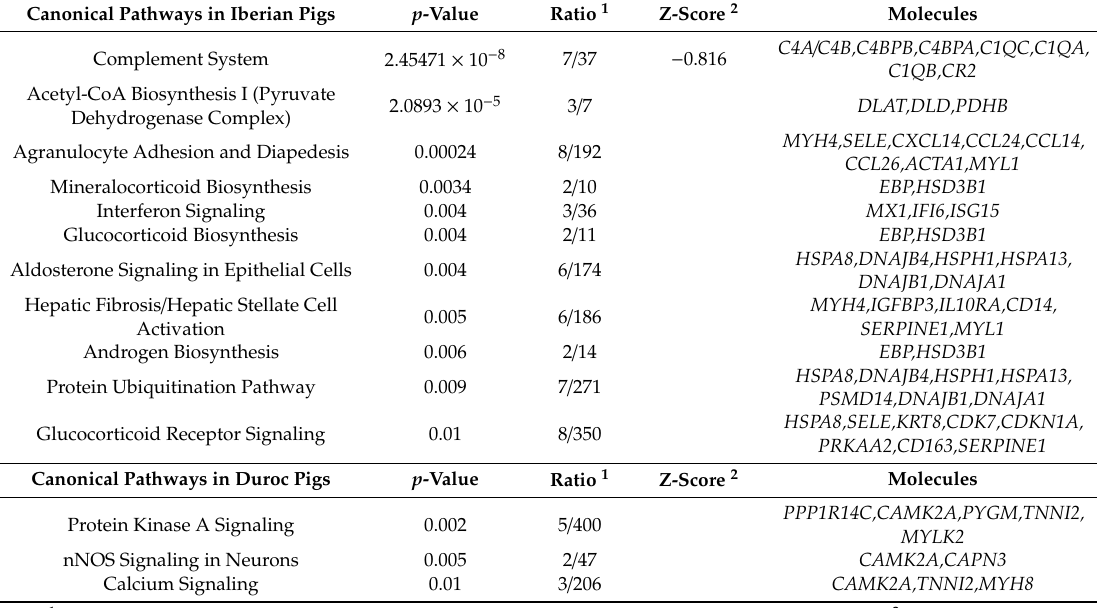
Table 4. IPA-based list of pathways in the set of DEGs according to diet in Iberian and Duroc pigs ( p -value ≤